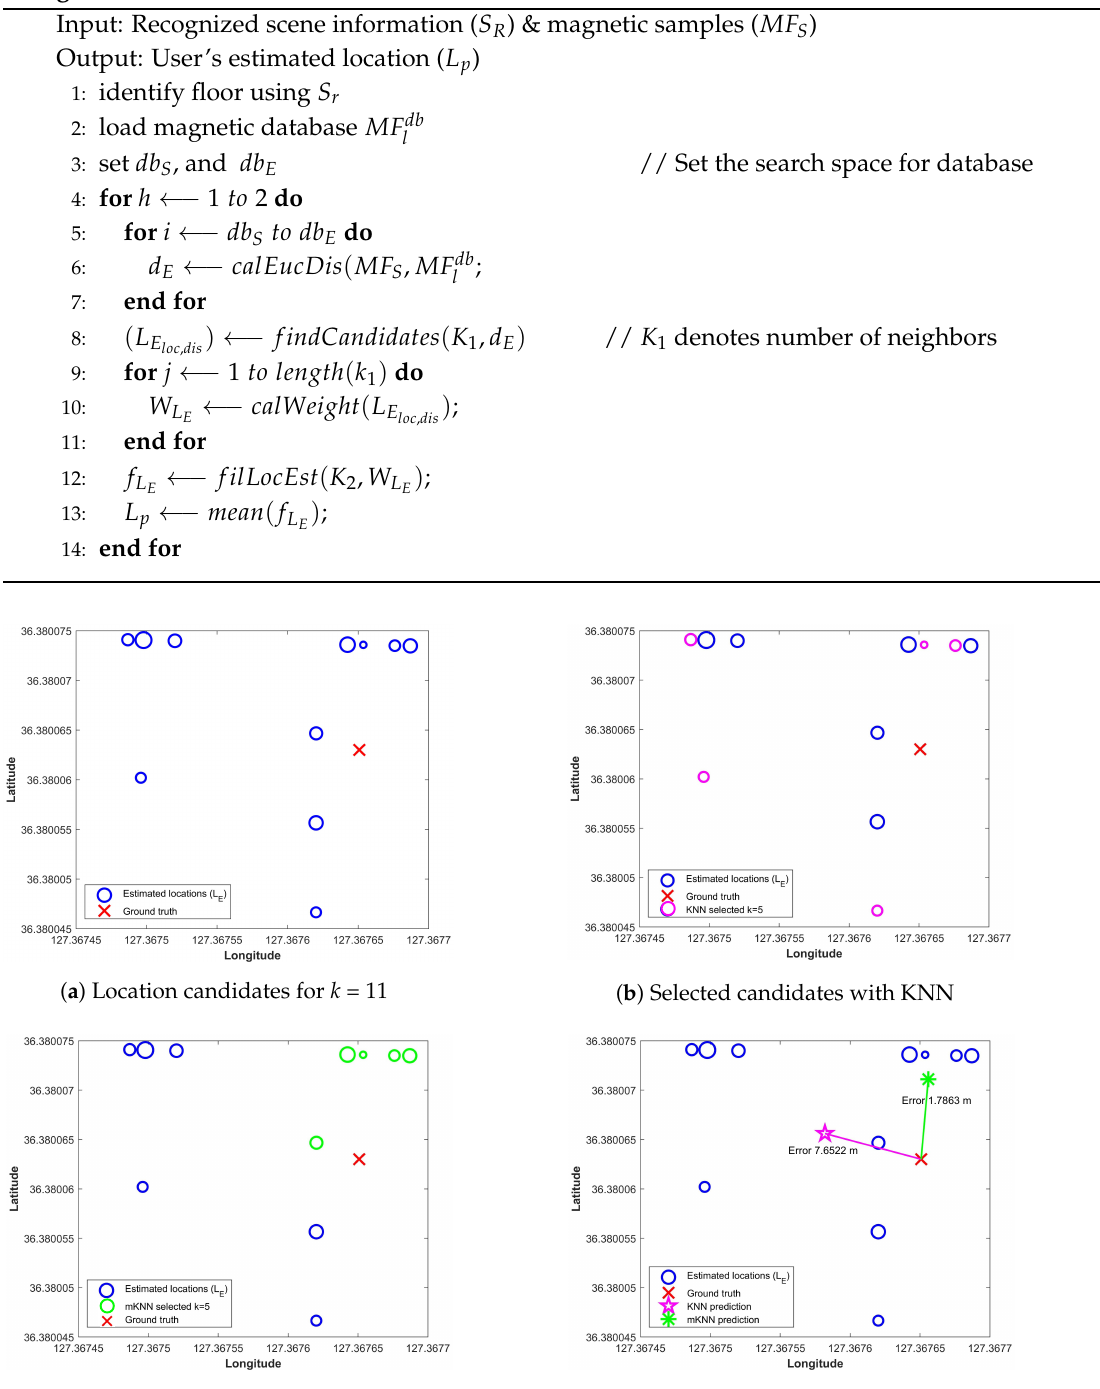
Algorithm 1: Find user location